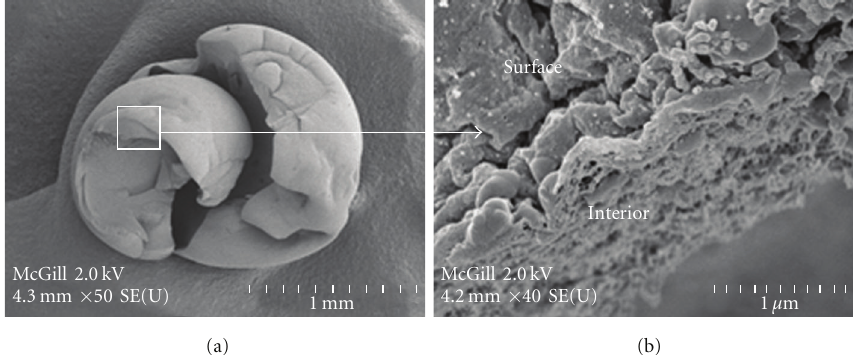
Figure 3: SEM images of the surface and interior structure of the GCAC microcapsules. (a): full view at 50 × ; and (b): surface and interior structure at